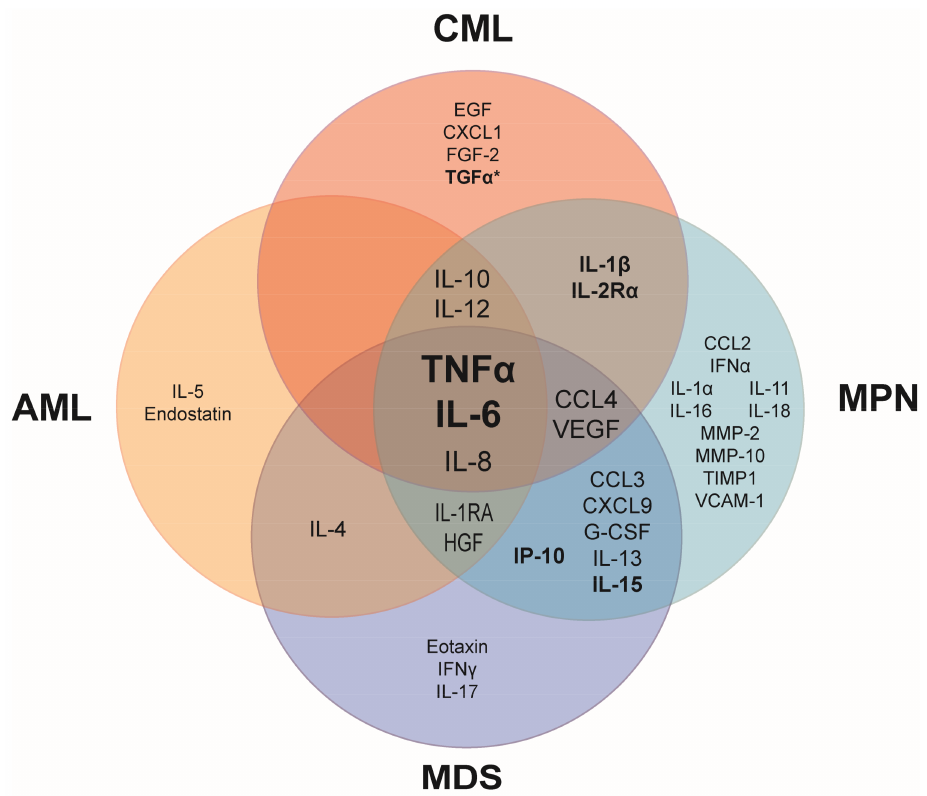
Figure 1. Common upregulated pro- and anti-inflammatory cytokines in patient blood plasma or serum compared to healthy controls. Elevated tumor necrosis factor alpha (TNF α ) and interleukin 6 (IL-6) are shared among the major myeloid malignancies. Cytokines in bold have been linked to prognostic survival in at least one hematopoietic malignancy. *Prognostic survival is correlated with transforming growth factor alpha (TGF α ) only when IL-6 is also elevated. AML, acute myeloid leukemia;